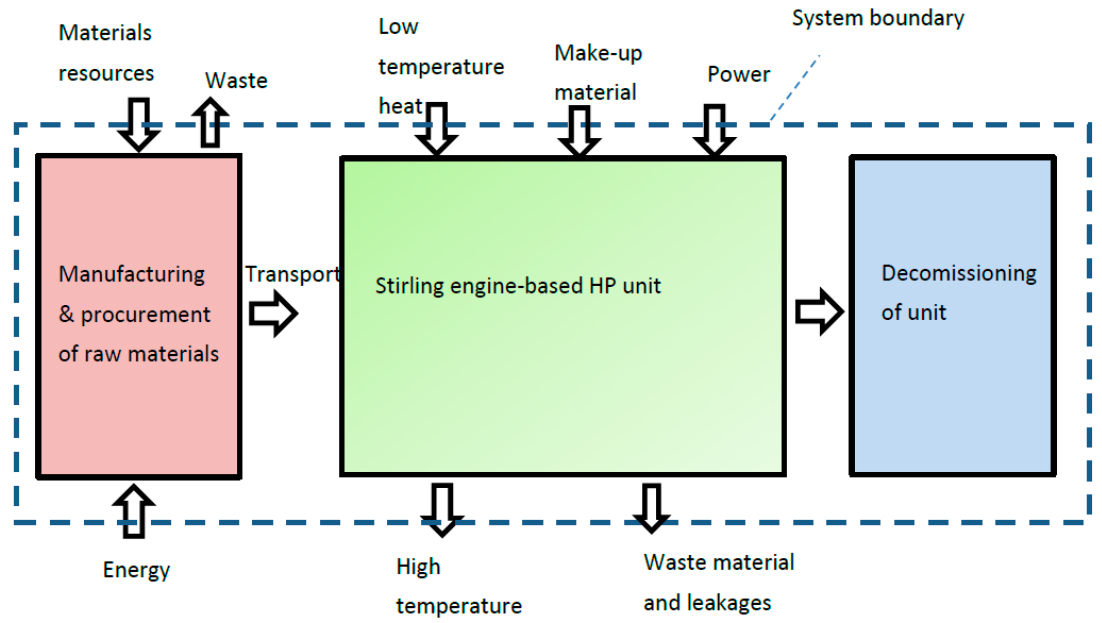
Figure 2. Schematic diagram of the system boundary for life cycle assessment of SE HP.